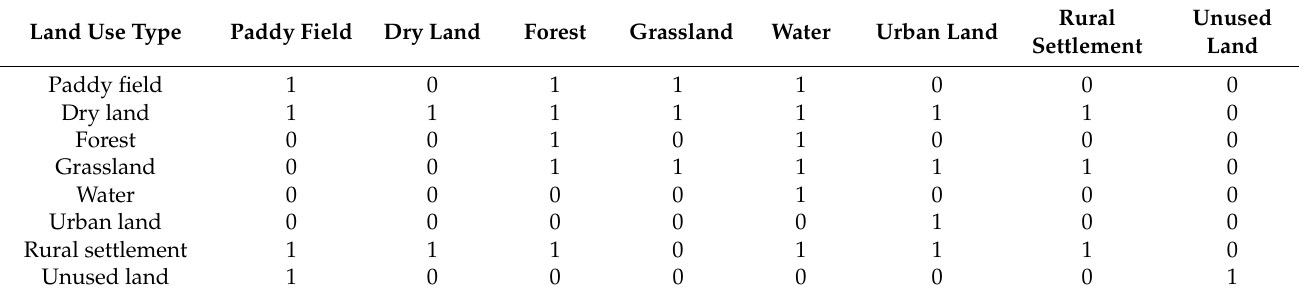
Table A3. Land use conversion cost matrix of SEC scenario.